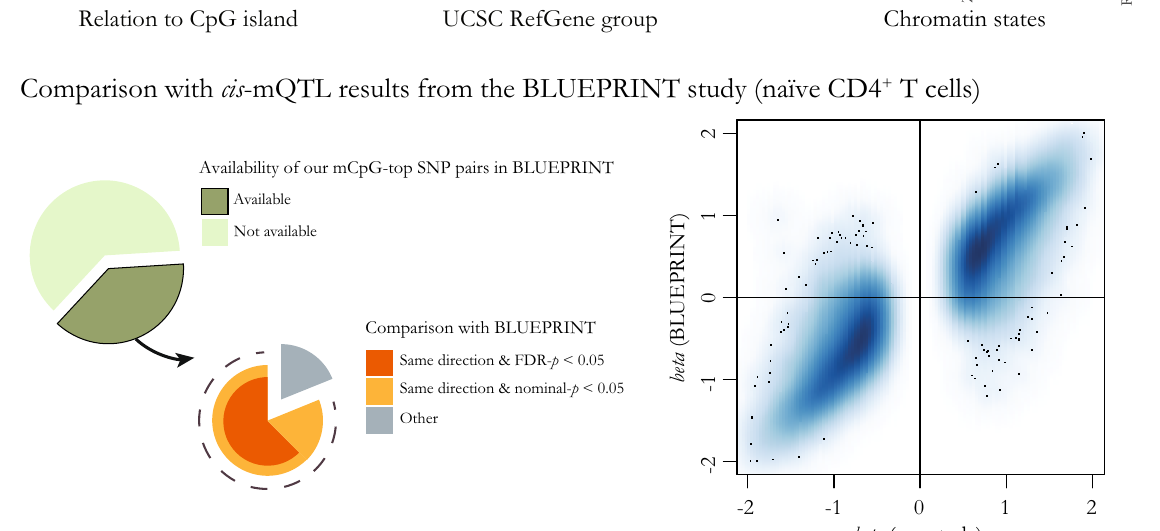
Fig. 1 Characterization of genome-wide signi fi cant cis -mCpGs and cis -mQTLs. a Enrichment of the identi fi ed cis -mCpGs in comparison to all tested CpGs in relation to UCSC CpG islands and gene functional regions (annotations from R IlluminaHumanMethylationEPICanno.ilm10b2.hg19 package) and chromatin states modeled for CD4 + T cells (annotations from Roadmap Epigenomics Project, sample #E043). Signi fi cant enrichment/depletion are shown using upwards/downwards arrows, respectively. b Percentage of our identi fi ed cis -mCpGs available in the BLUEPRINT study and the comparison between the two studies regarding the direction of effect and signi fi cance of association for the lead mSNPs are shown on the left. Comparison between the effect sizes found in our study and in BLUEPRINT are shown on the